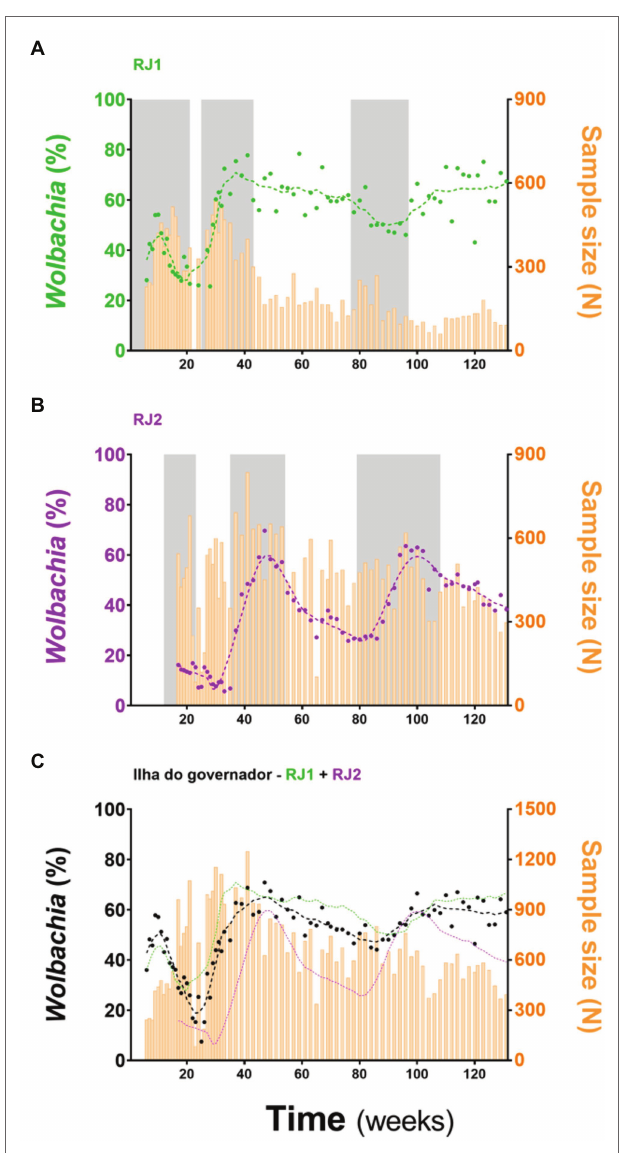
FIGURE 2 | Wolbachia ’s introgression into Ilha do Governador. Adult w Mel- harboring Aedes aegypti were mass-released in RJ1 and RJ2 areas, covering the entire territory of Ilha do Governador (Rio de Janeiro). Release intervention was carried out in three rounds (gray shading). Invasion profiles are depicted separately for (A) RJ1 and (B) RJ2, plus an aggregate of both for (C) an overall representation. Following the left Y-axis, Wolbachia prevalence indexes (%) are color coded and plotted as dots plus second degree, seven-neighbors, moving averages (dashed lines). Following the right Y-axis, sample sizes are plotted as histograms (orange bars). Time (weeks), since the beginning of adult releases (Week 1, August 2017) until recent days (Week 131, March 2020), is represented in the X-axis. Ticks are scaled for 20-week